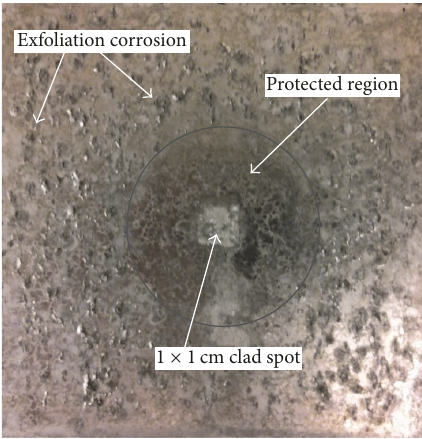
Figure 2: Optical microscopy of a cleaned central clad spot panel, 1 square cm clad